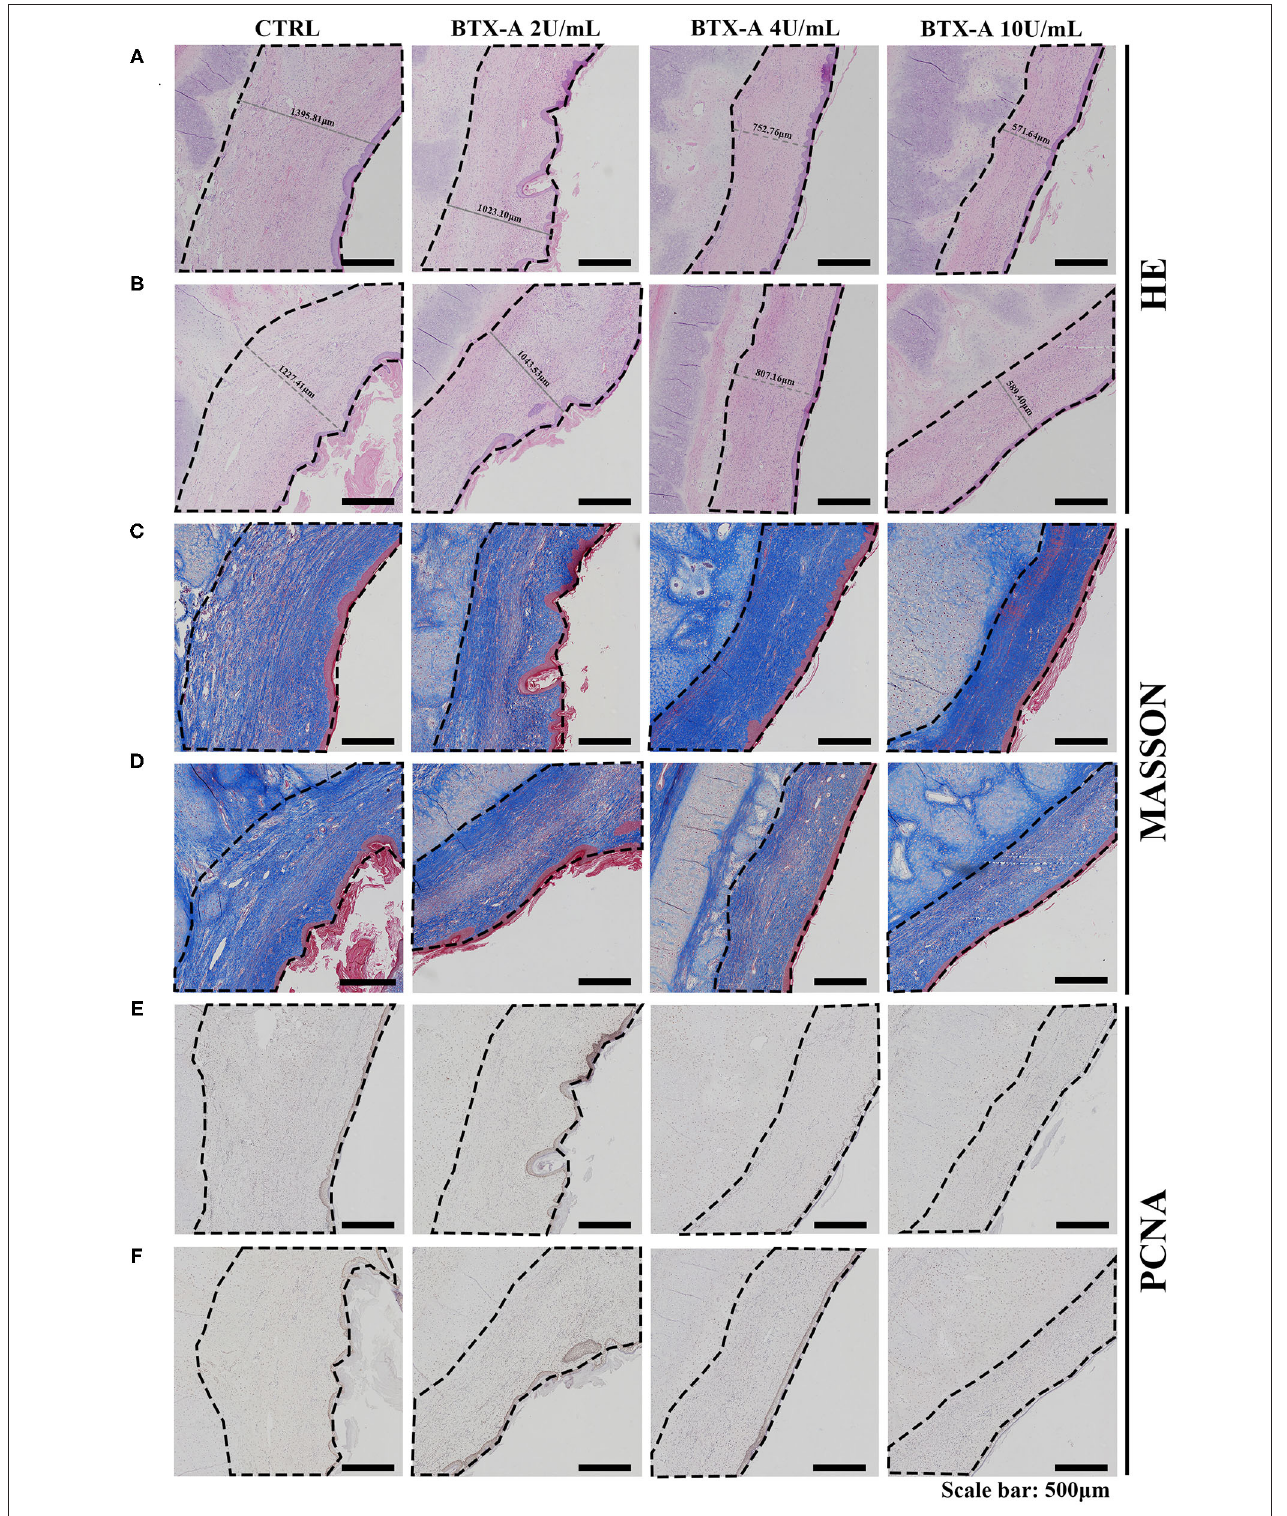
FIGURE 9 | Results at 6 weeks after the treatment. The scar tissues were marked with dotted lines. (A) HE staining of the different treated scar samples in the SP overexpression group; (B) HE staining of the different treated scar samples in the SP normal-expression group; (C) Masson trichrome staining of the different treated scar samples in the SP overexpression group; (D) Masson trichrome staining of the different treated scar samples in the SP normal-expression group; (E) PCNA of the different treated scar samples in the SP overexpression group; (F) PCNA of the different treated scar samples in the SP normal-expression group.